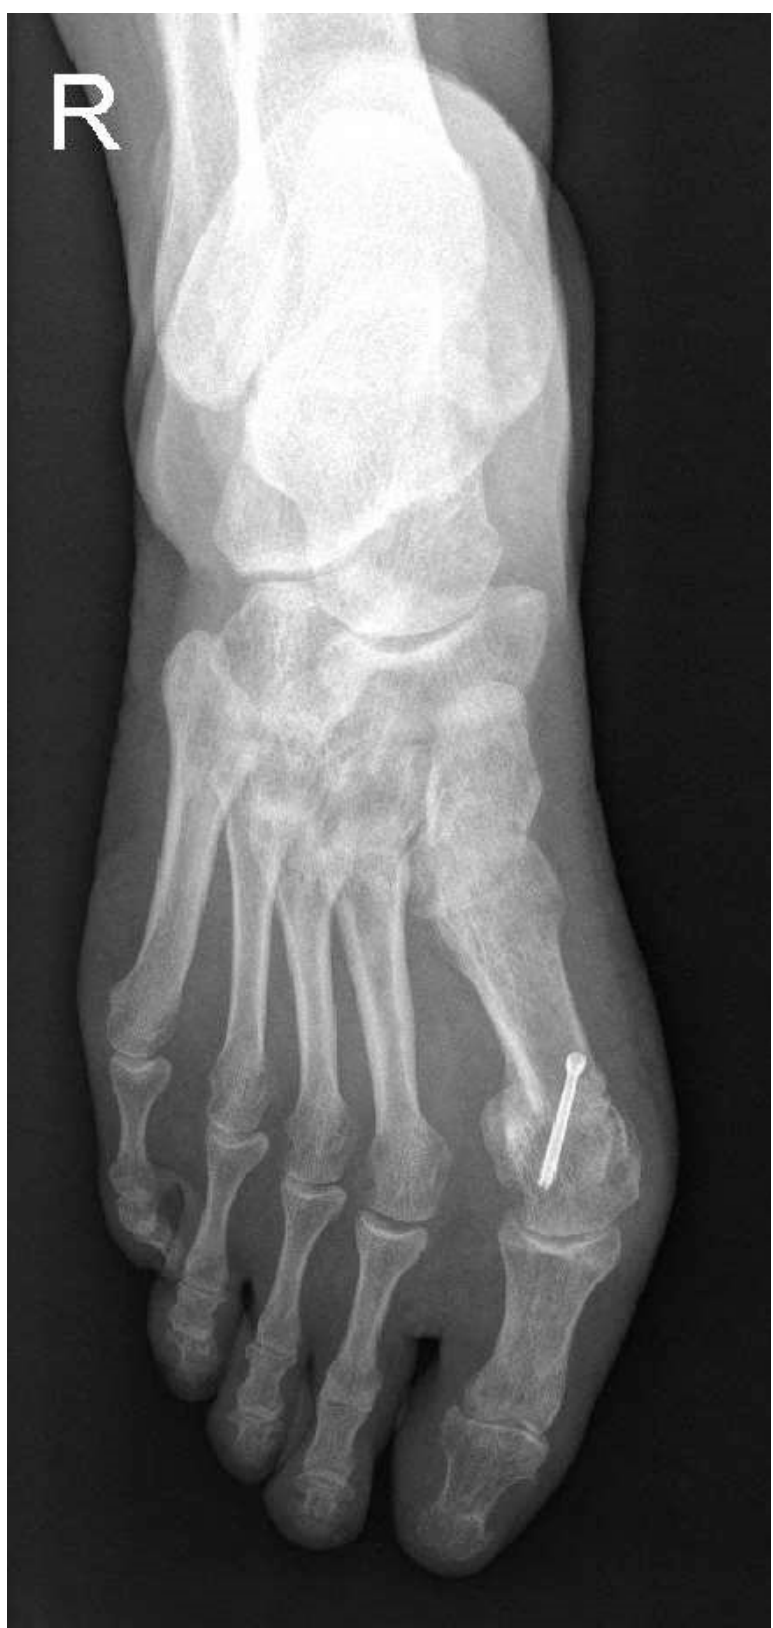
Figure 5. Postoperative weight-bearing anteroposterior image after 12